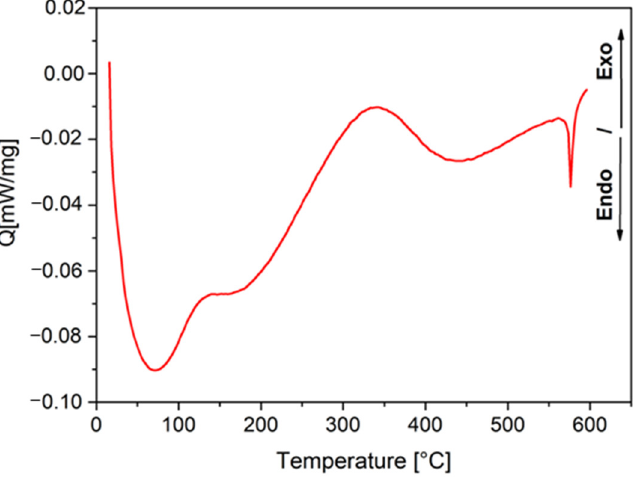
Figure 9. DSC curve for copper ore.